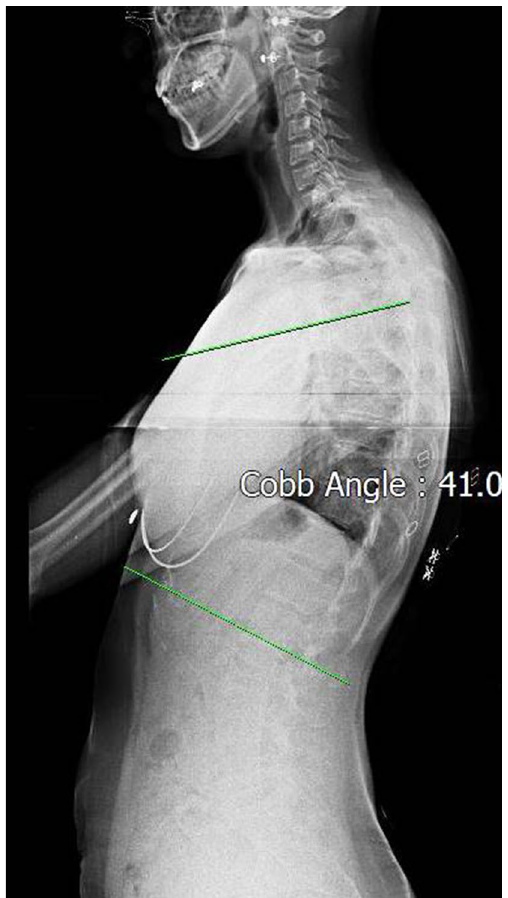
Figure 3. The measurement of Cobb’s angle using picture achieving and communication system